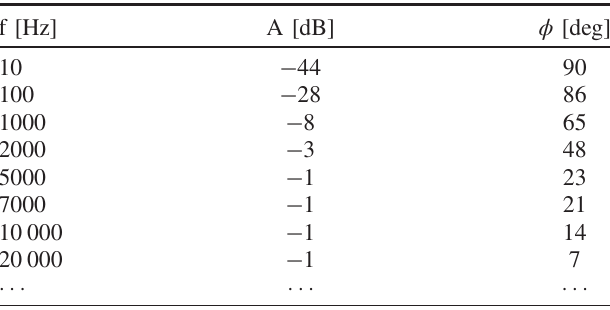
TABLE IV. Example set of measurements as taken by one of the pairs during the original lab at campus